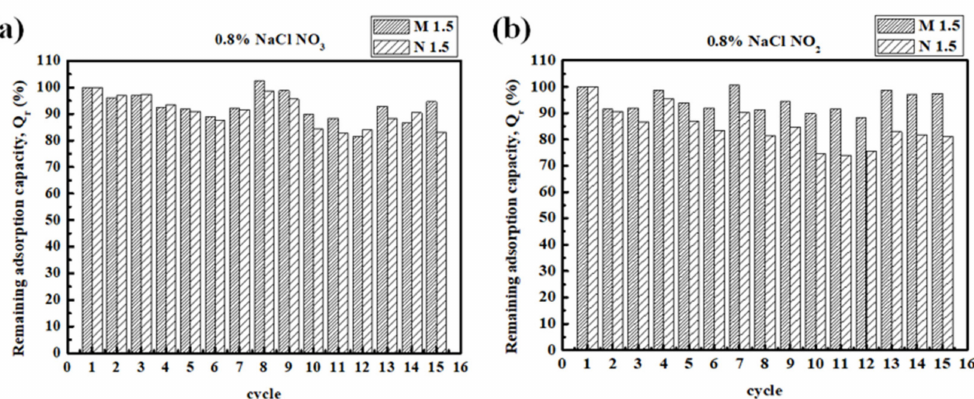
Figure 9. Regeneration of PEGDA-MTAC and PEGDA-AMHC using 0.80 wt % of NaCl in 15 cycles of adsorption/desorption ( a ) the remaining adsorption capacity of nitrate; ( b ) the remaining adsorption capacity of